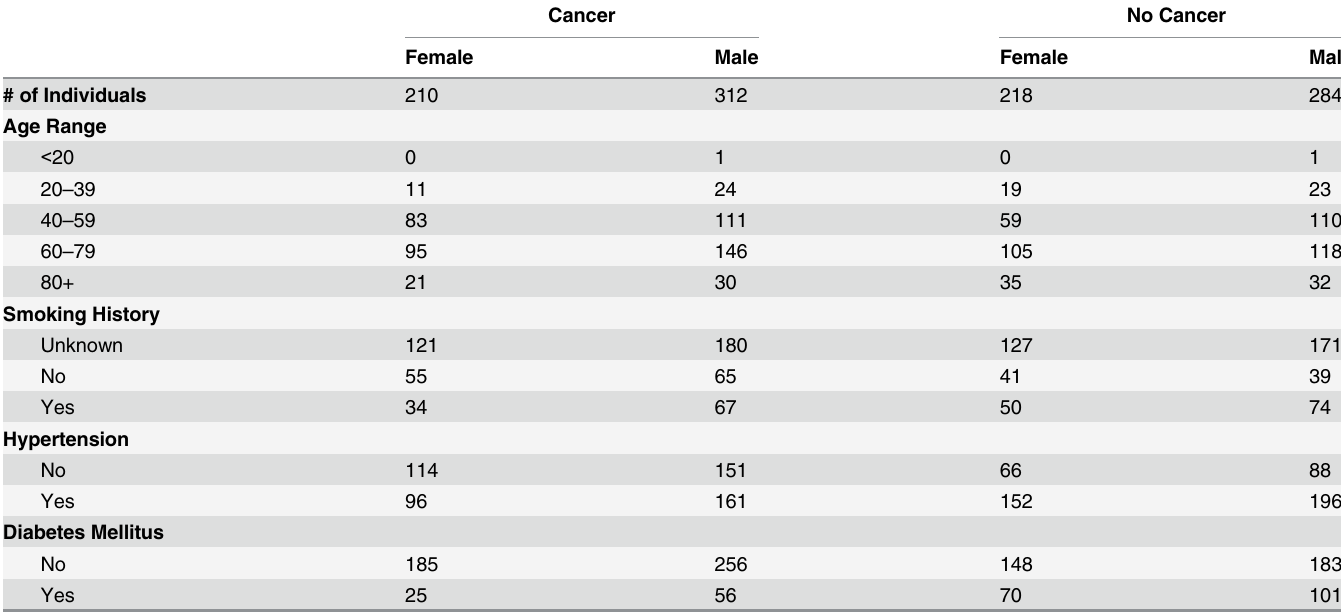
Table 1. Descriptive population statistics.